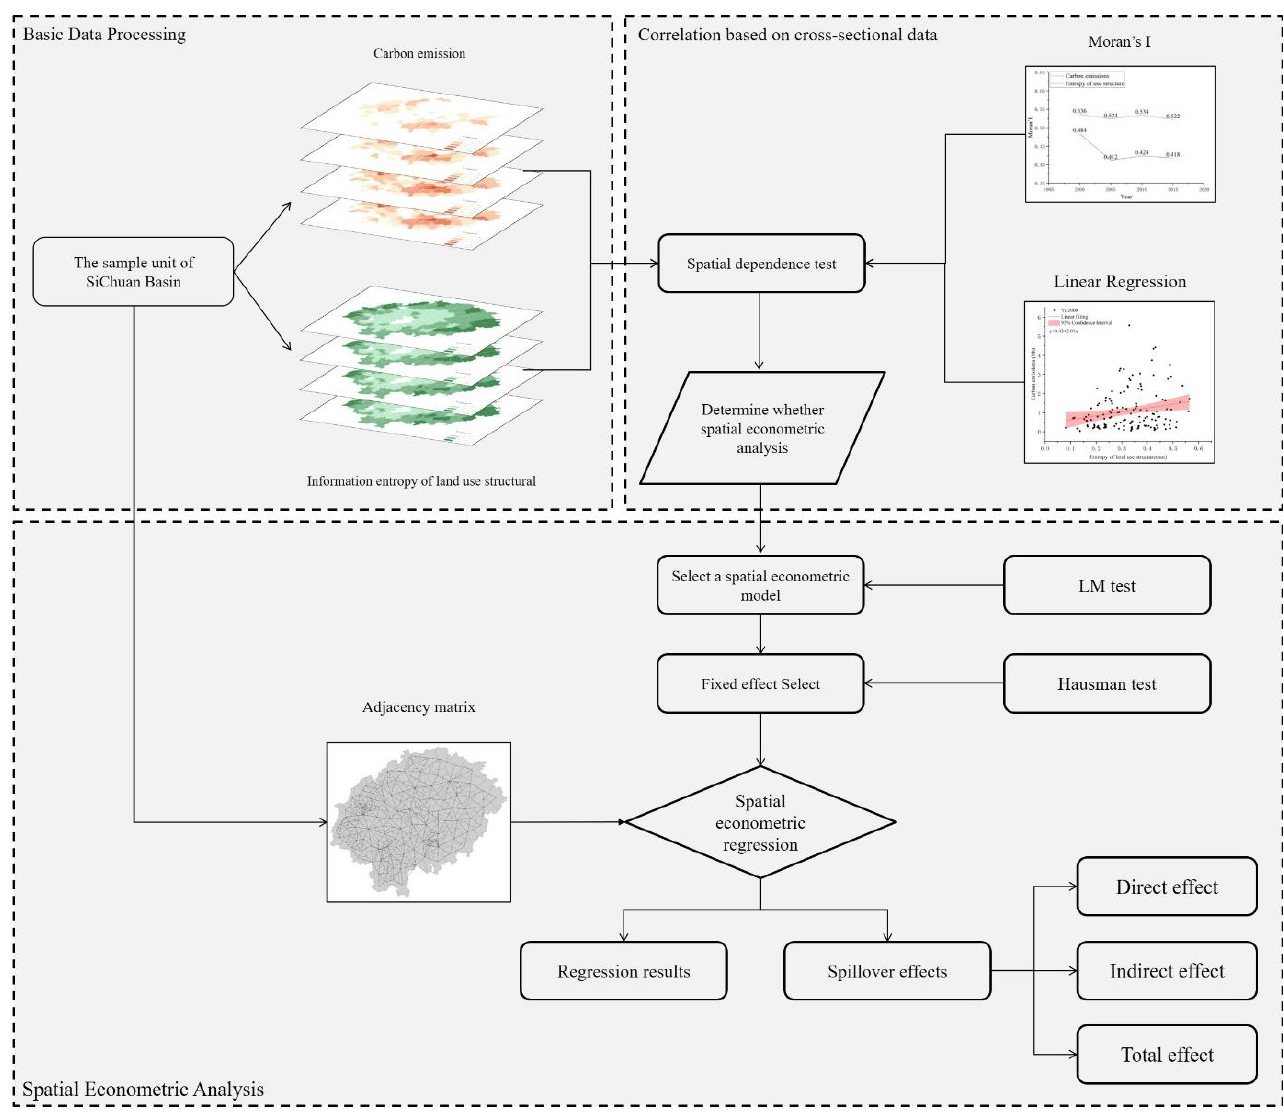
Figure 2. Research